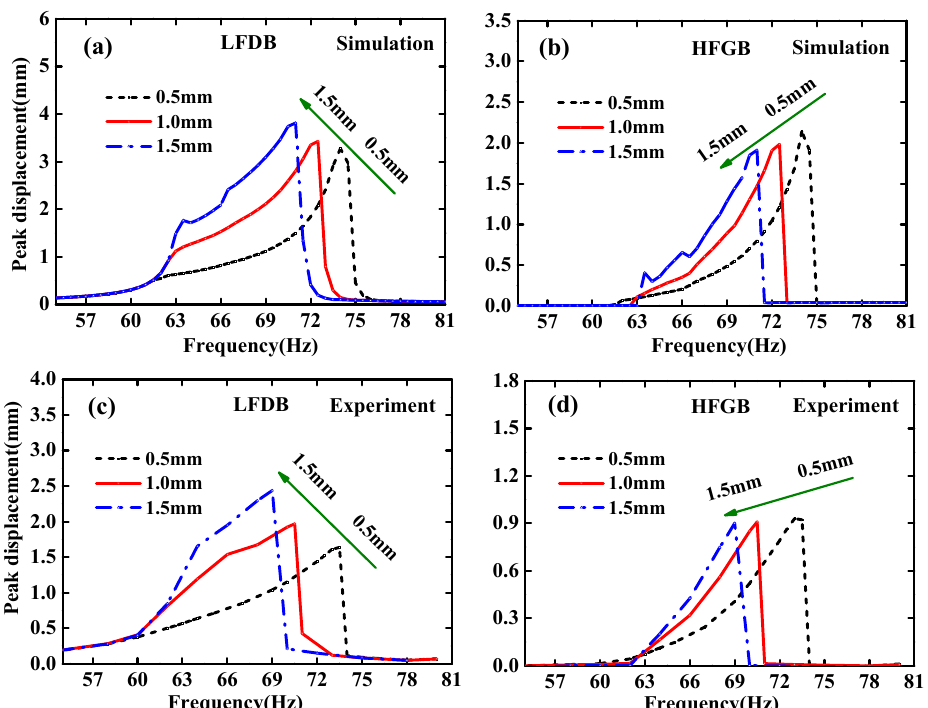
Figure 8. Frequency responses of the peak displacement of LFDB and HFGB for various rope-margins under the condition of a = 0.6 g and k 0 = 1150 N/m: ( a ) simulation frequency responses of LFDB; ( b ) simulation frequency responses of HFGB; ( c ) experimental frequency responses of LFDB; ( d ) experimental frequency responses of HFGB.